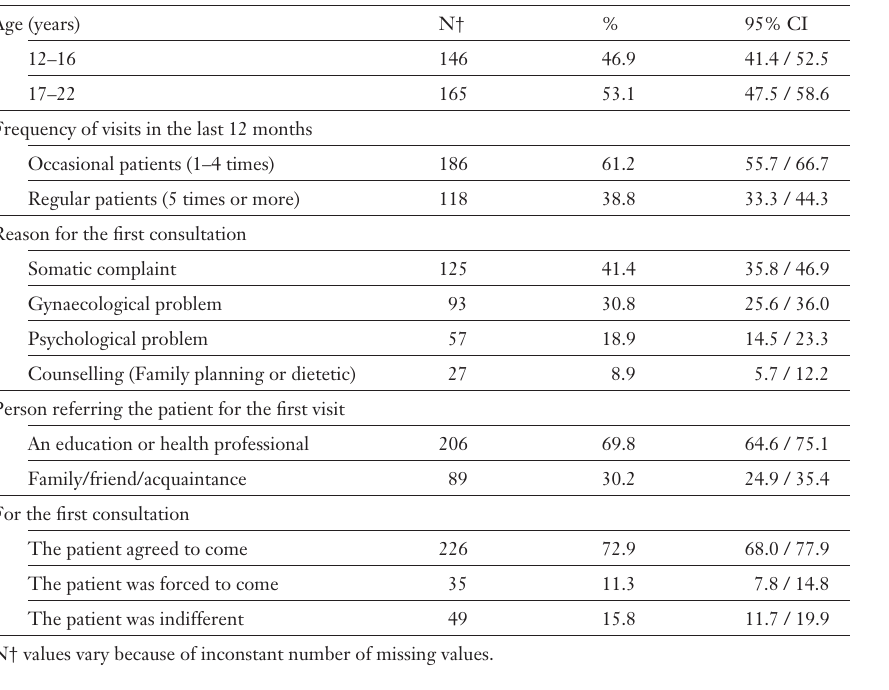
Factors associated with female satisfac- tion with direct and indirect links in a log-linear